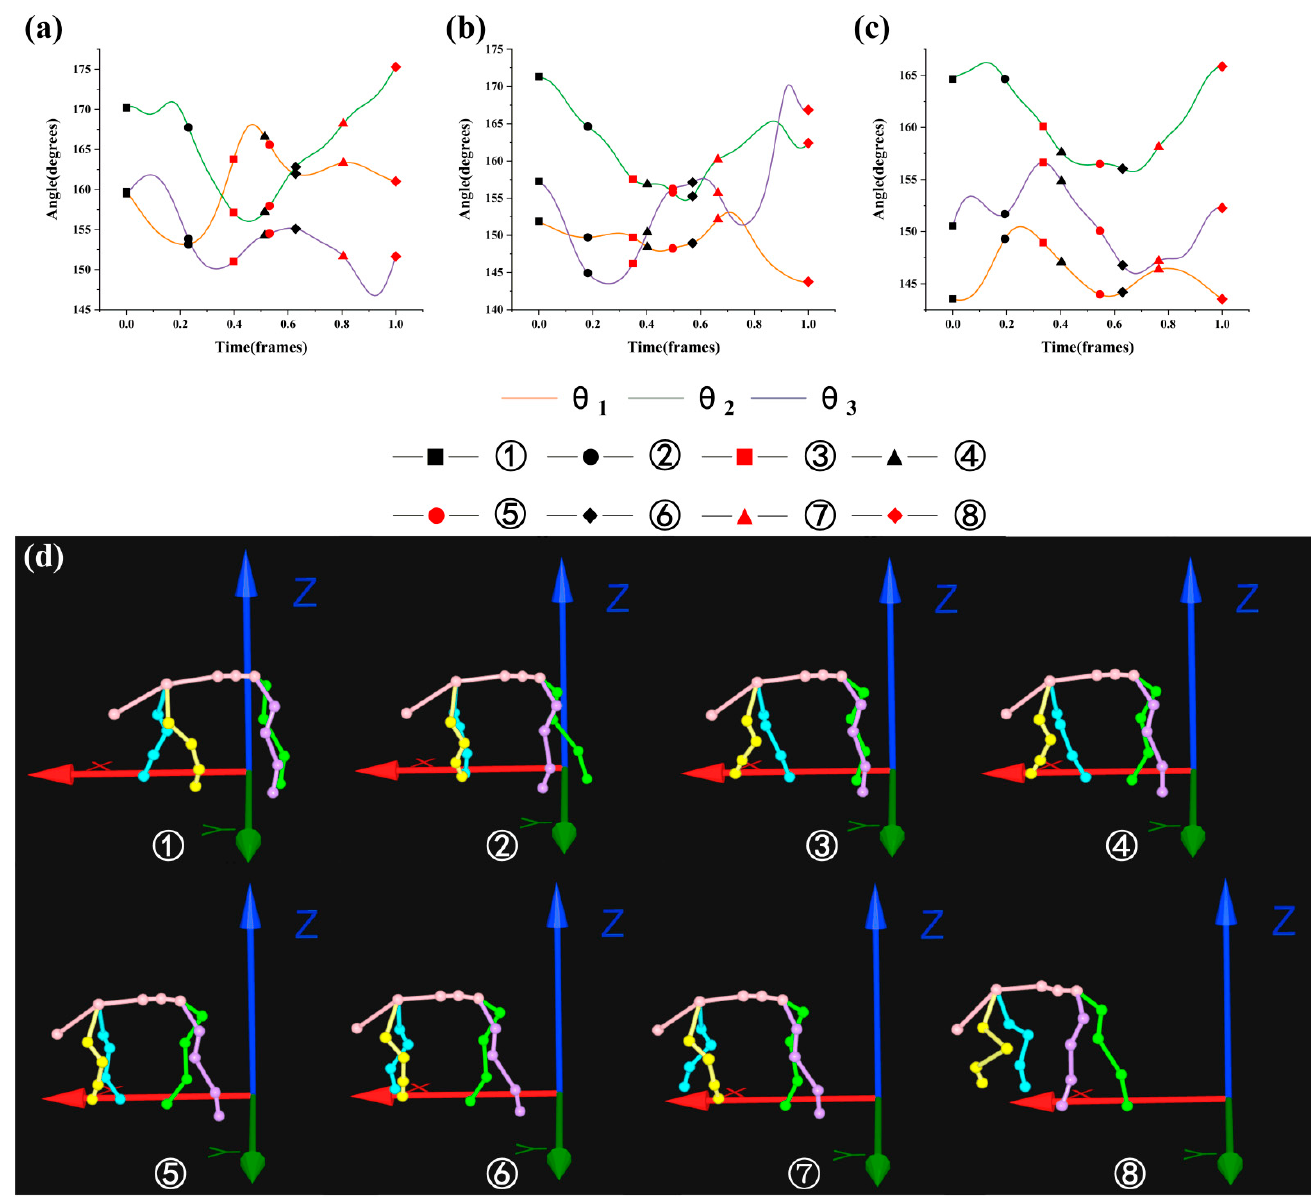
Figure 6. Motion state of goat: ( a – c ) are angle changes of θ 1 , θ 2 , and θ 3 under the slope of 5°; ( d ) eight movements under the slope of 5°.